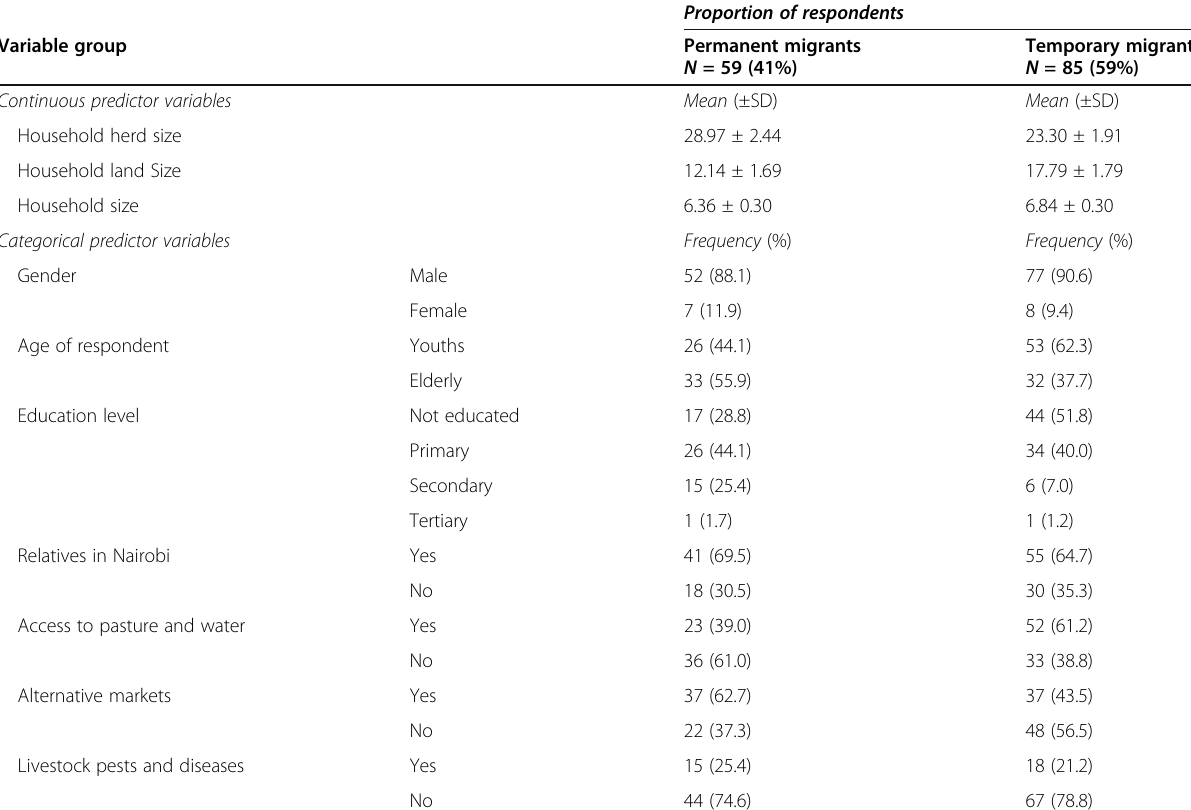
Proportion of respondents